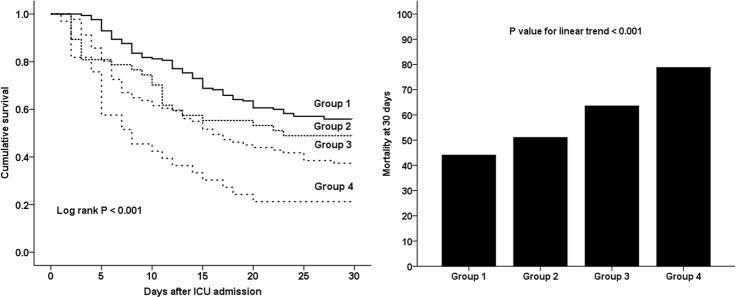
Kaplan-Meier survival estimate and 30-day mortality among the 4 groups categorized by %FOpreCRRT and %FOtotal.There was a significant difference in survival among the 4 groups (P < 0.001). 30-day mortality was the highest in Group 4, followed by Group 3, Group 2, and Group 1 (78.8% vs. 62.6% vs. 51.1% vs. 44.1%; P value for the linear trend < 0.001). Group 1: n = 170, %FOpreCRRT < 10% and %FOtotal < 10%; Group 2: n = 47, %FOpreCRRT ≥ 10% and %FOtotal < 10%; Group 3: n = 91, %FOpreCRRT < 10% and %FOtotal ≥ 10%; and Group 4: n = 33, %FOpreCRRT ≥ 10% and %FOtotal ≥ 10%. %FOpreCRRT = percentage of fluid overload from baseline body weight during 3 days prior to CRRT initiation. %FOtotal = percentage of total fluid overload from baseline body weight from 3 days before CRRT initiation to ICU discharge. ICU = intensive care unit.